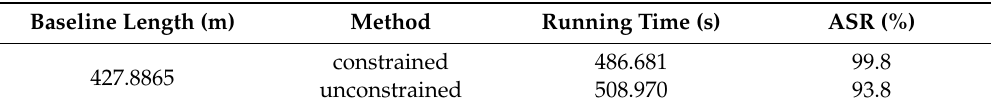
Table 3. Comparison of experimental results for the Teaching Experiment building, Wuhan.